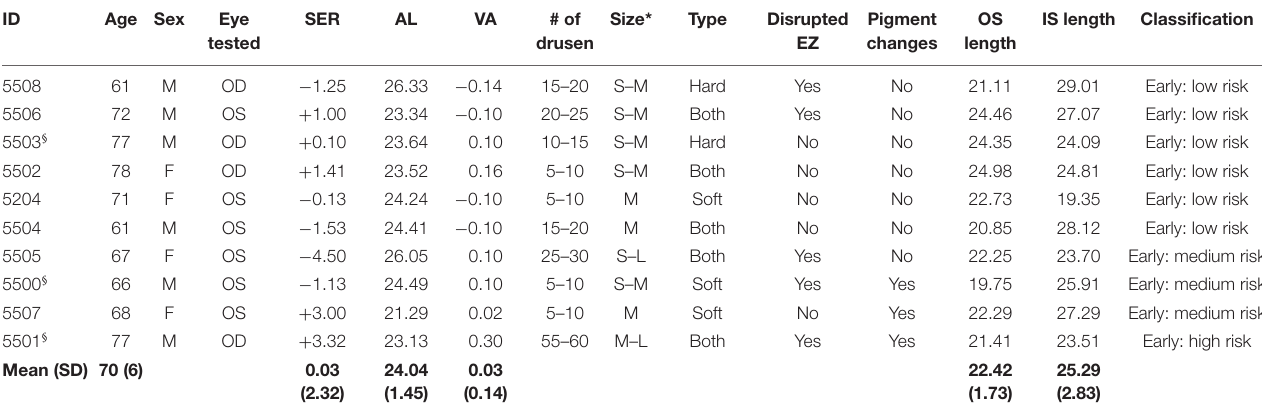
TABLE 1 | Clinical characteristics of the 10 participants with early AMD presenting age, sex, eye tested, spherical equivalent refractive error (SER), ocular axial length (AL), logMAR visual acuity, frequency of drusen, drusen size and type, the presence of disrupted ellipsoid zone (EZ), pigmentary changes, and clinical classification of AMD according to NICE NG 82 (NICE guideline [NG82],